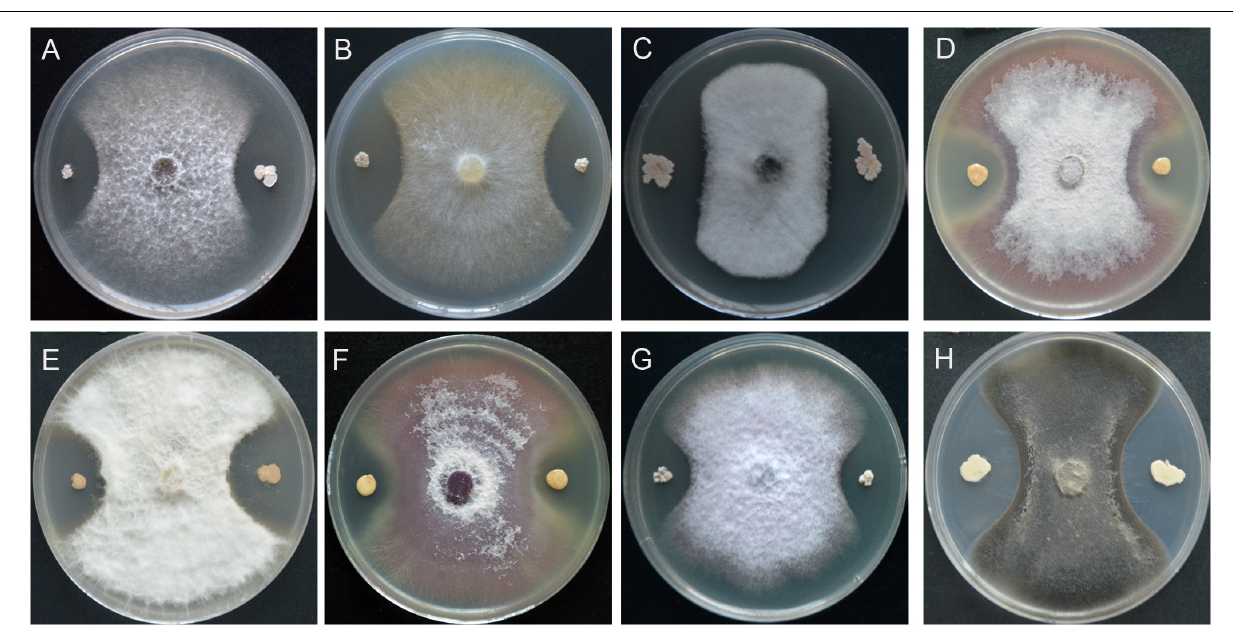
FIGURE 2 | Effect of strain YB-130 on growth of eight plant pathogenic fungi. (A) Gaeumannomyces graminis var. tritici , (B) Rhizoctonia cerealis , (C) Bipolaris sorokiniana, (D) Fusarium oxysporum f.sp. niveum , (E) Fusarium oxysporum f.sp. capsicum , (F) Fusarium oxysporum f.sp. cucumebrium , (G) Pythium myriotylum , (H) Cercospora apii